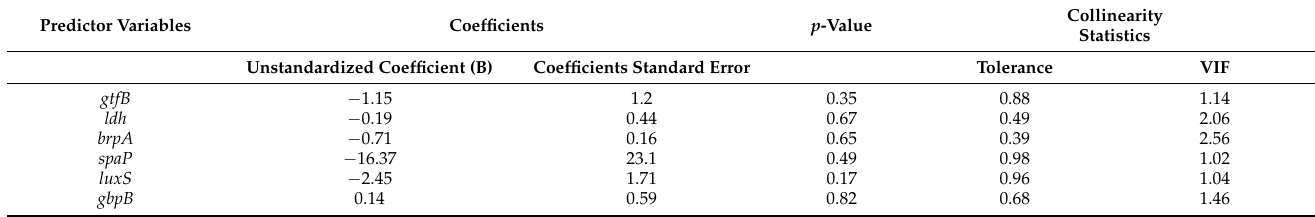
Table 3. Analysis of the association between the PMS of cariogenic dental biofilm and the expression level of virulence genes using multiple linear